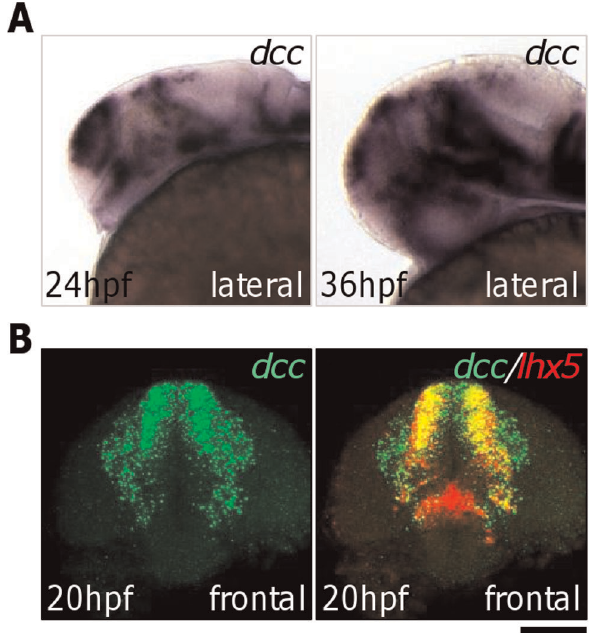
Figure 2. Expression patterns of dcc and netrin . ( A ) dcc is expressed in the dorsal telencephalic region at 24 hpf and 36 hpf. ( B ) dcc and lhx5 are co-expressed in the dorsal telencephalon at 20 hpf. ADt neurons are migrating from their medial positions in the neural tube to lateral positions at 20 hpf. Scale bar: 100 m m for lateral view; 60 m m for frontal view.